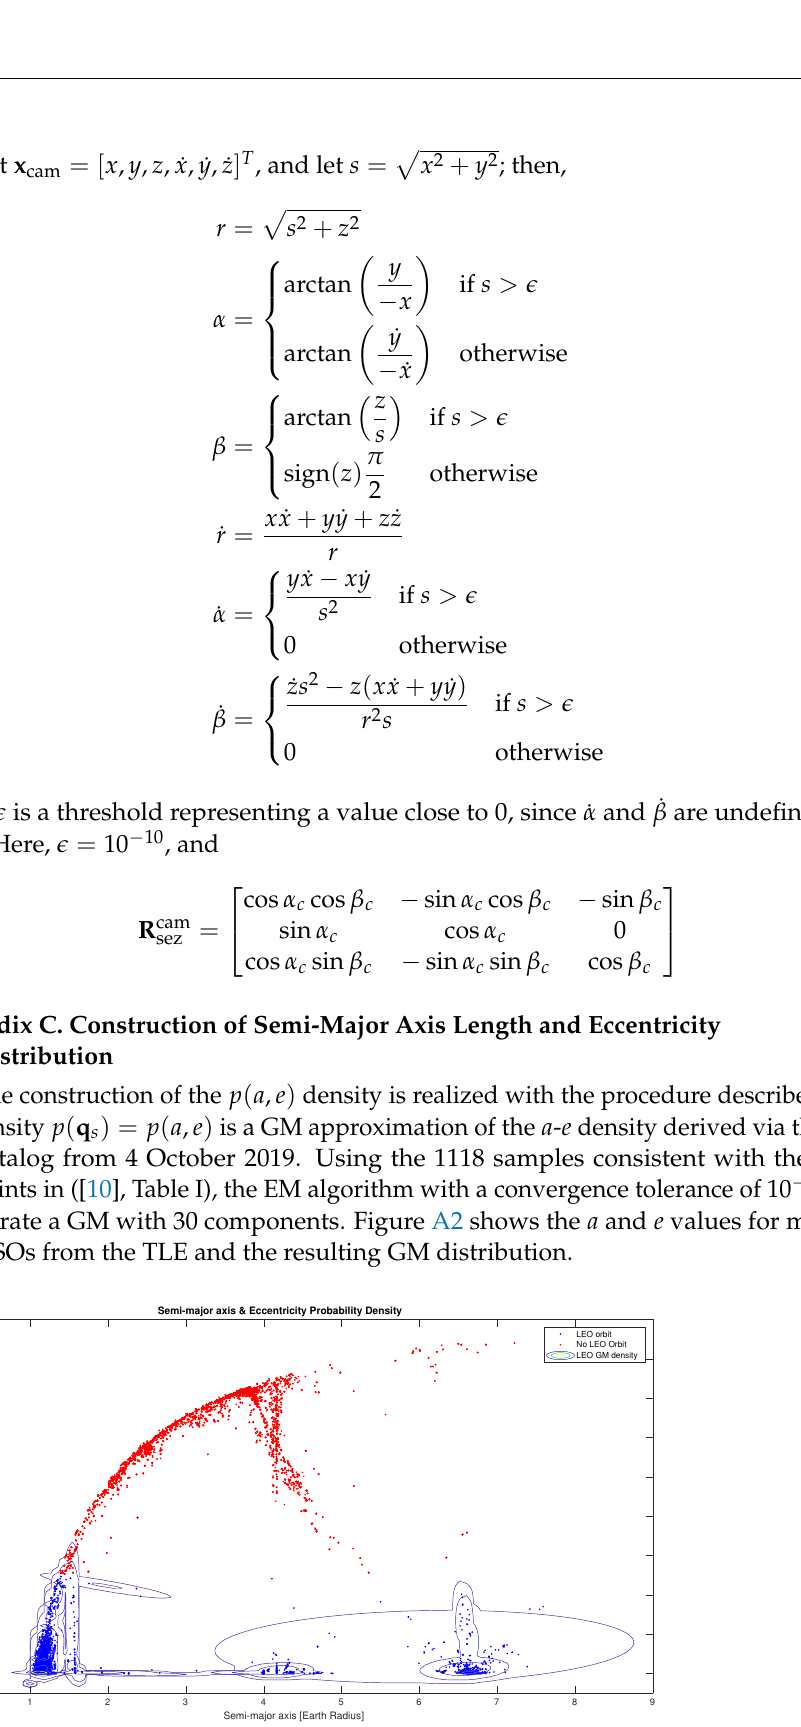
Figure A2. Probability density of the semi-major axis (measured in units of Earth radius) and eccentricity of LEO targets. The red points show the non-LEO targets and blue points the LEO targets of the TLE file of 2–6 October 2019. Contour lines indicate the resulting GM probability density using 30 components and a convergence tolerance of 10 − 7 , replicated 10